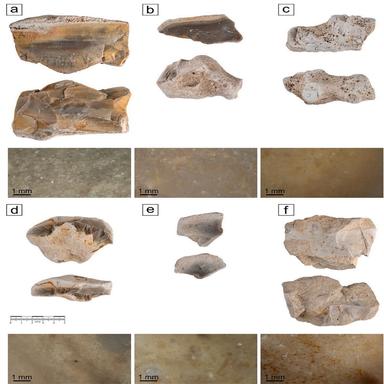
Six lithotypes of chert raw material found in Załęze ˙ gully. The representative specimens and their microscopic view in the water immersion. (a) Tabular chocolate flint; (b) Non-tabular chocolate flint; (c) Non-tabular poorly developed chocolate flint; (d) Chert with transitional characteristics between chocolate flint and other KCU varieties; (e) non-chocolate flint KCU chert variety; (f) Silicified limestone with cherts (photo of representative specimens by W. Ochotny).